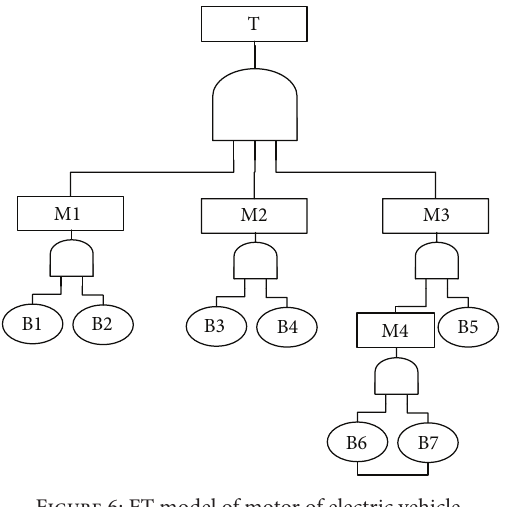
Figure 6: FT model of motor of electric vehicle.